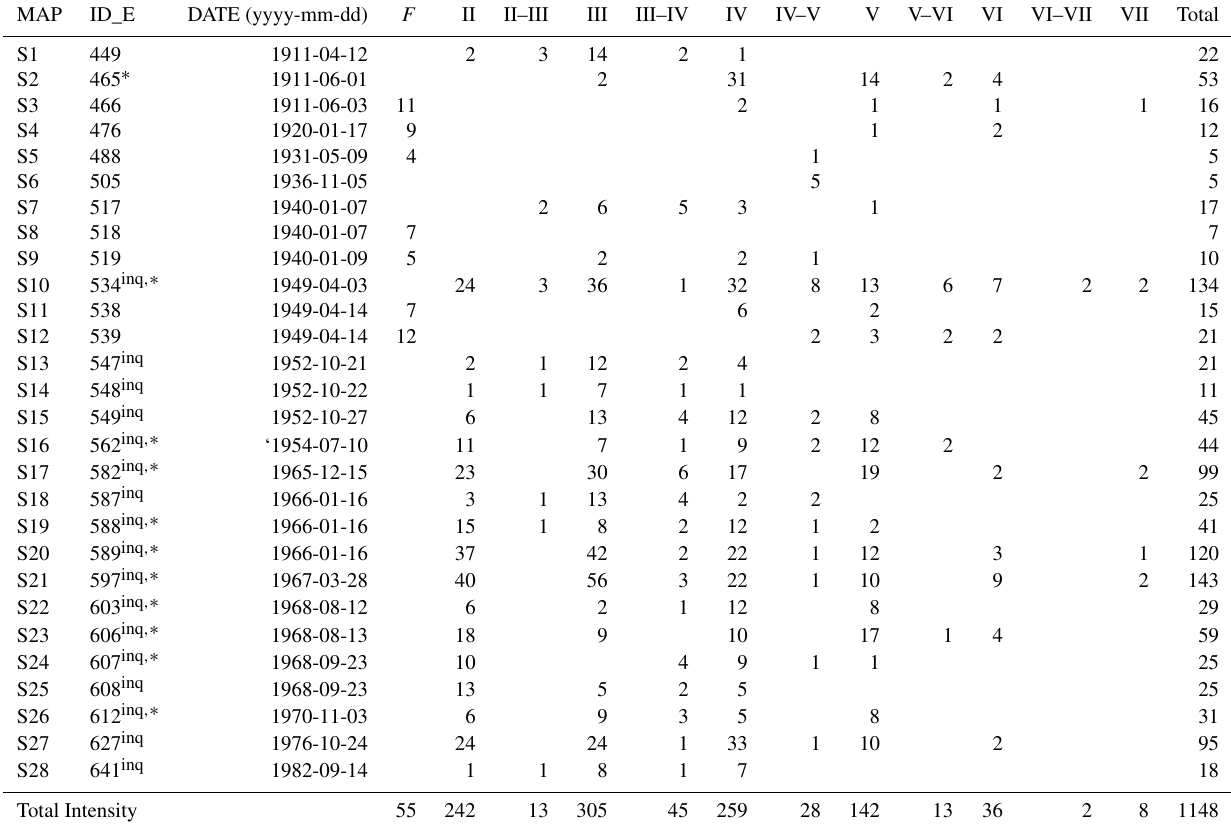
Table 2. Summary of intensity (EMS-98) data for the largest earthquakes in the Hainaut coal area and which are mapped in the Atlas. MAP: map number in Supplement. inq : earthquake with an official ROB intensity survey; ∗ : earthquake used for Hainaut intensity attenuation modelling. Total: amount of IDPs with mean intensity of I min and I max